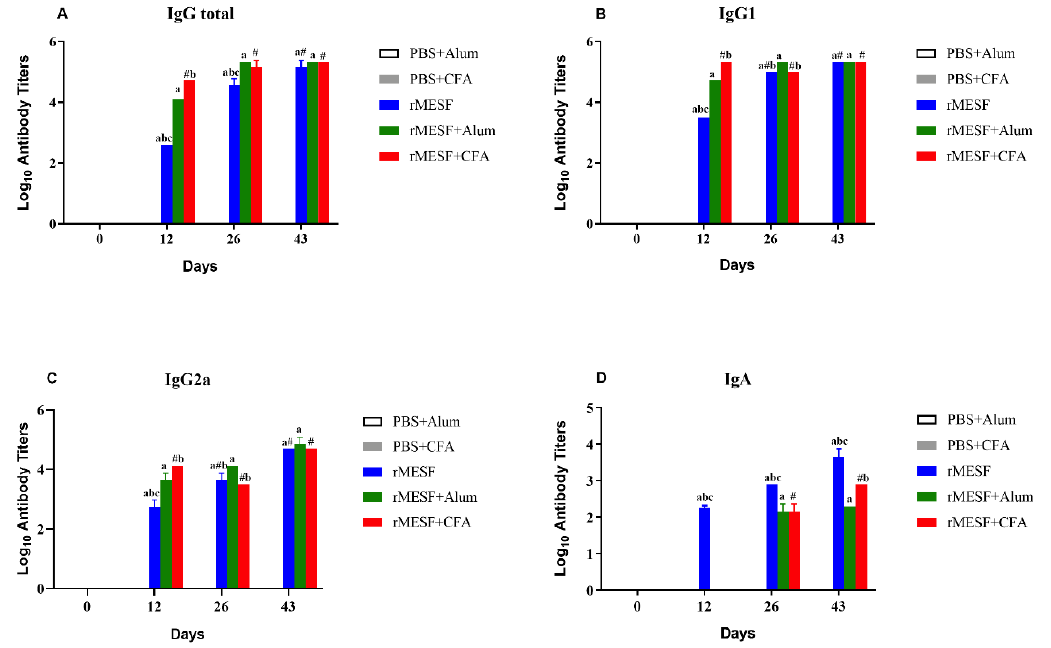
Figure 3. Antibody serum titers in controls and immunized mice. ( A ) Serum IgG. ( B ) IgG1. ( C )